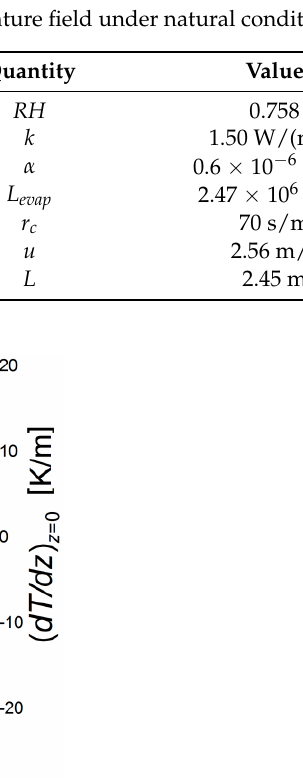
Figure 5. Annual courses of heat flux on the ground surface. 3. Ground Temperature Field with an Installed Heat Exchanger 3.1. The Heat Flux Extracted from the Ground In order to simulate the heat transfer in the ground with an installed heat exchanger, the time dependence of the heat flux taken from the ground should be known. A simplified model was adopted in which it was assumed that: •